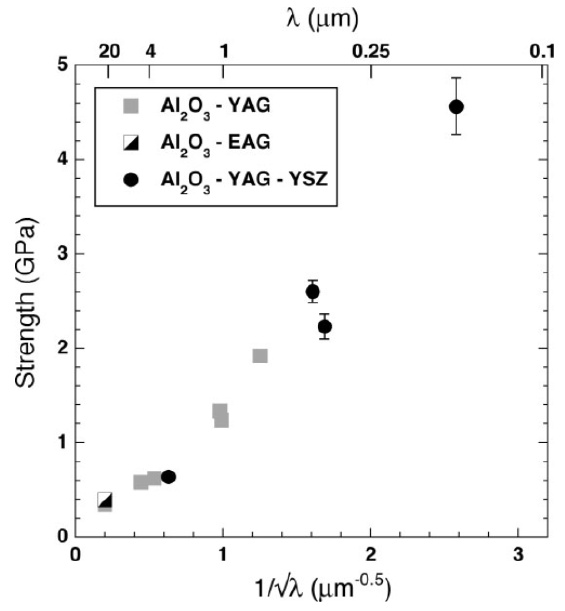
Figure 12. Influence of average domain size, λ , on the flexure strength of bulk specimens of directionally solidified eutectic oxides. Reproduced with permission from Reference [13], Copyright © 2007 WILEY-VCH Verlag GmbH & Co. KGaA, Weinheim.